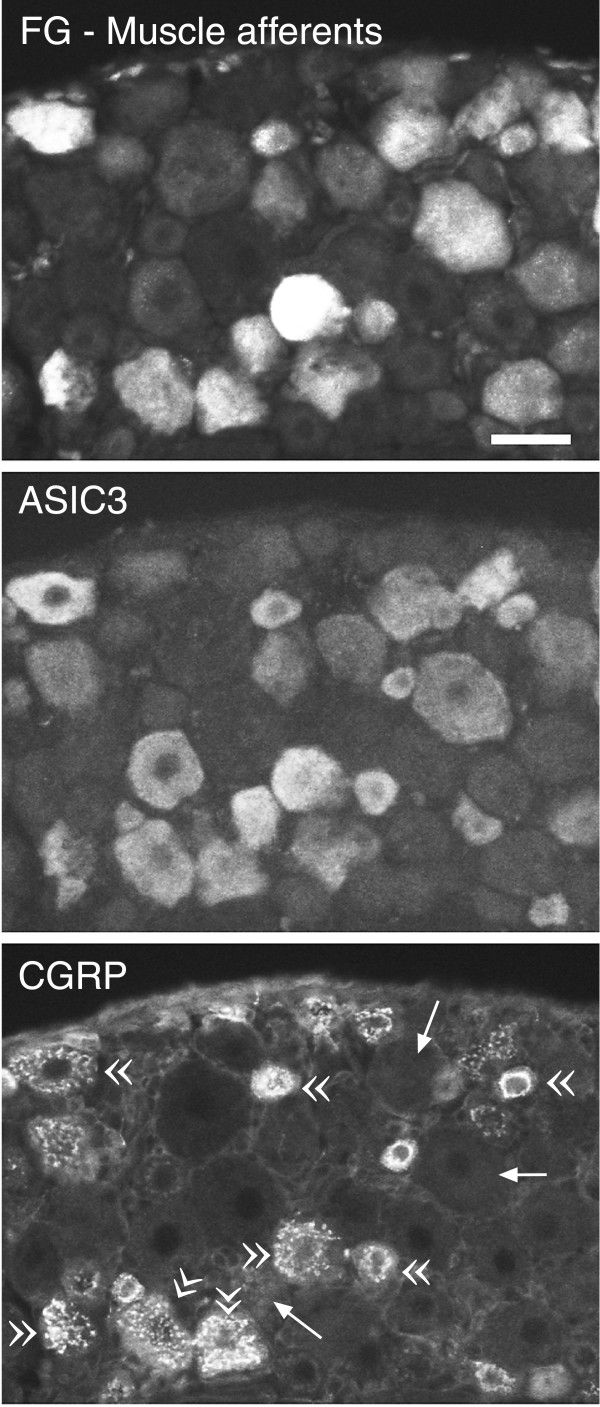
Most muscle afferents that express ASIC3 also express CGRP. Three photomicrographs of the same DRG section showing: fluorogold transported from a muscle injection (top); ASIC3 immunoreactivity (middle); CGRP immunoreactivity (bottom). Double arrowheads in the bottom image indicate cells positive for each label. Arrows indicate cells positive for fluorogold and for ASIC3, but not for CGRP. 83% (168/202) of ASIC3-positive muscle afferents were CGRP-positive (373 total muscle afferents counted). Scale bar, 40 μm.